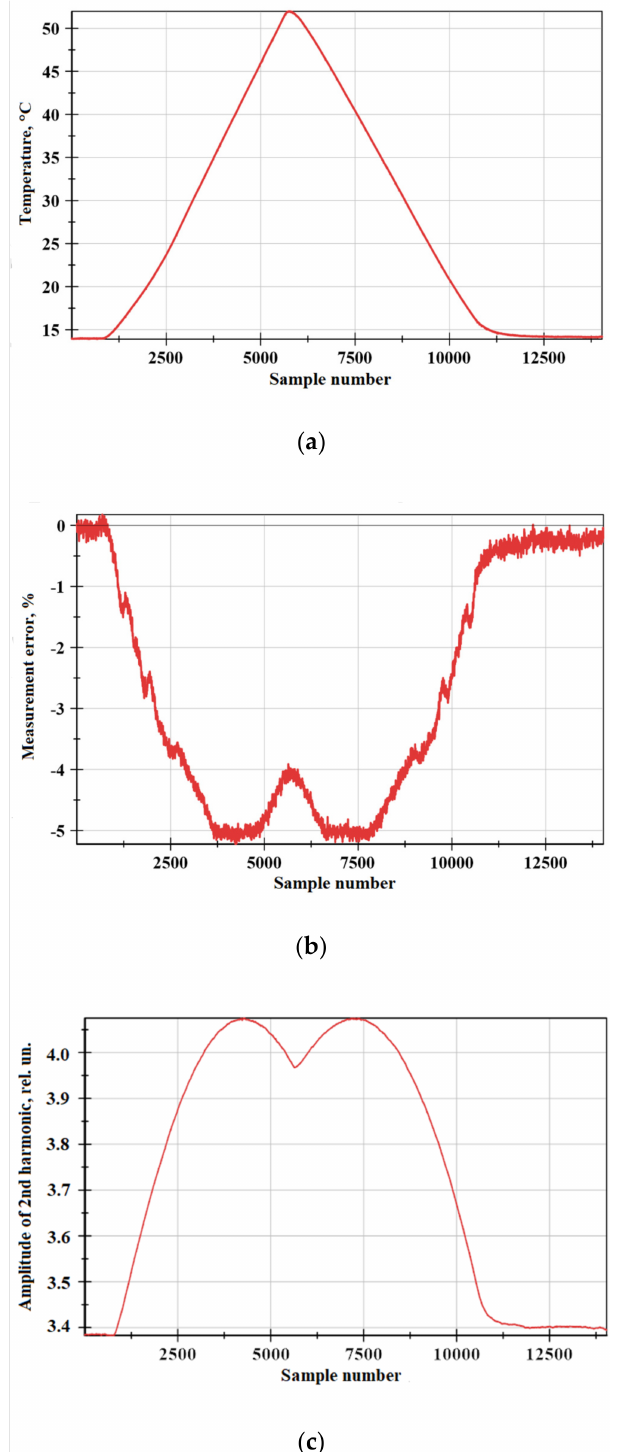
Figure 10. The experimental results: ( a ) Quarter-wave plate’s temperature vs. sample number; ( b ) relative amplitude error of FOCS vs. sample number; ( c ) amplitude of second harmonic vs. sample number. The primary current was 50% of the nominal